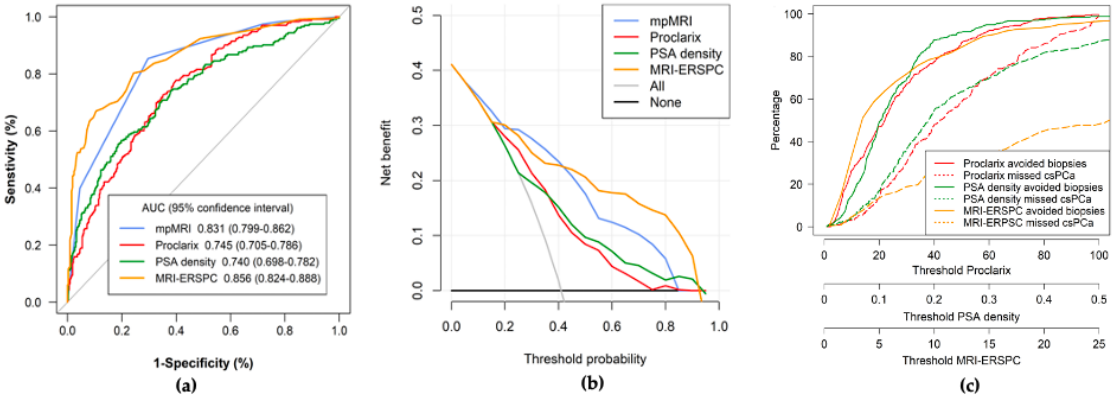
Figure 1. Efficacy ( a ), net benefit ( b ) and clinical utility ( c ) of Proclarix, PSAD and MRI-ERSPC model for csPCa detection in the overall population.